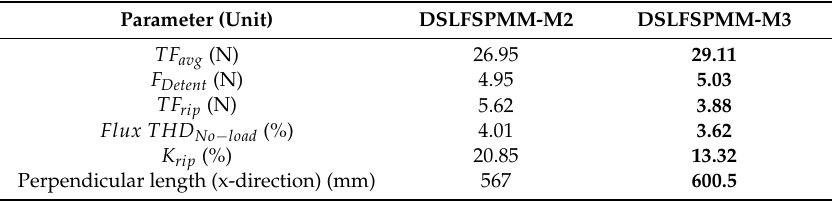
Table 5. Modified parameter and performance comparison of DSLFSPMM-M2 with and without APMES.